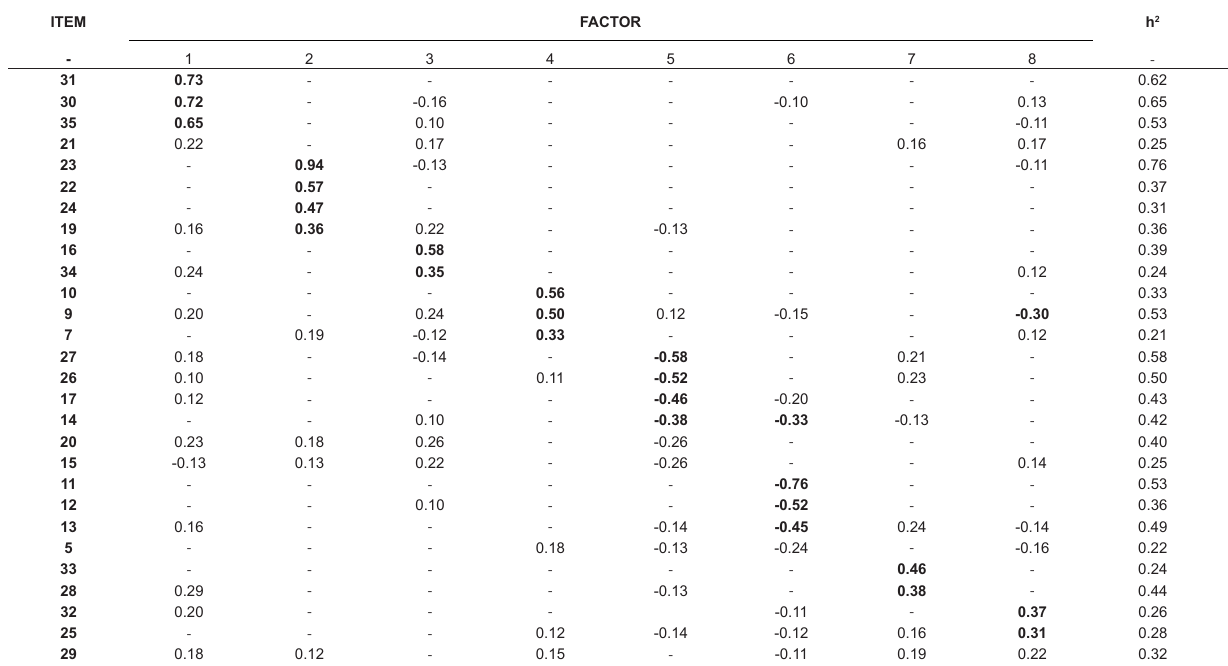
TABLE 1 Factor-pattern matrix for the 28-item work readiness skills scale